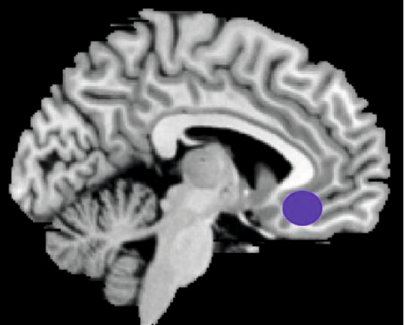
Figure 5: The location of ROI (rACC).